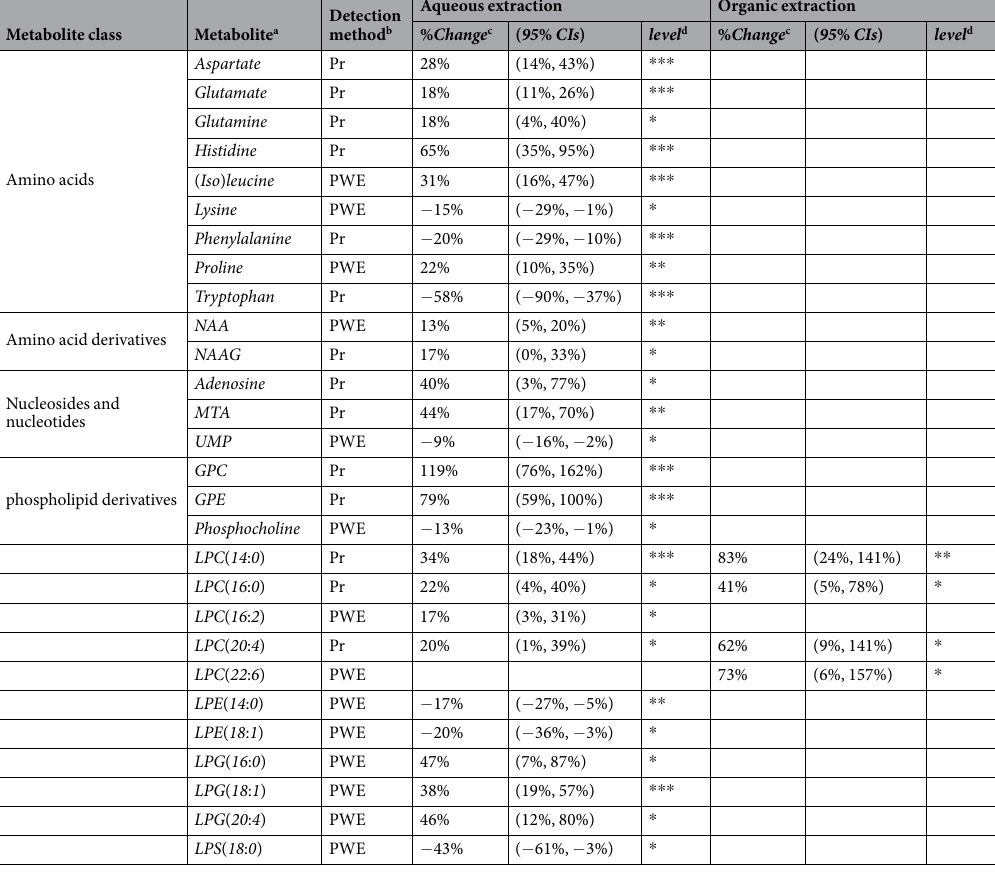
Table 1. Changes in metabolites detected in the hippocampus that differentiate the pallid from the WT genotype. a NAA: N-acetylaspartate, NAAG: N-Acetylaspartylglutamic acid, MTA: methylthioadenosine, UMP: uridine monophosphate, GPE: glycerophosphoethanolamine, GPC: glycerophosphocholine, LPA: lysophosphatidic acid, LPC: lysophosphatidylcholine, LPE, lysophosphatidylethanolamine,